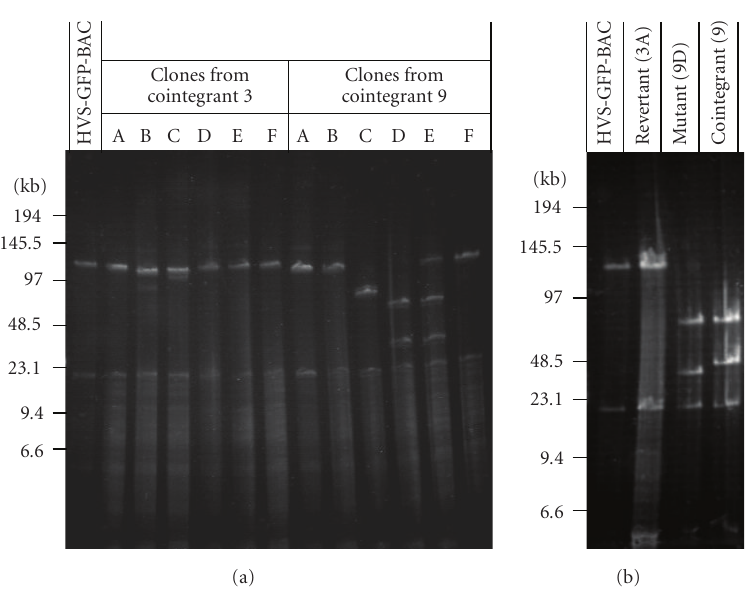
Figure 6: AgeI restriction analysis of clones derived from cointegrants during homologous recombination. (a) Cointegrants formed from the first stage of RecA-mediated recombination underwent a second recombination event to remove the integrated pKOV Kan plasmid. This second recombination event could result in either a revertant or a mutant genotype. Of the 12 colonies screened, clone 9D had the desired restriction pattern consistent with a mutated ORF51 gene. (b) The mutant clone 9D was digested and run alongside a revertant 3A and the cointegrant clone 9 from which it originated. The loss of the integrated pKOV Kan plasmid can be visualised by the 52kb band in the final lane decreasing in size by 7 kb to 45